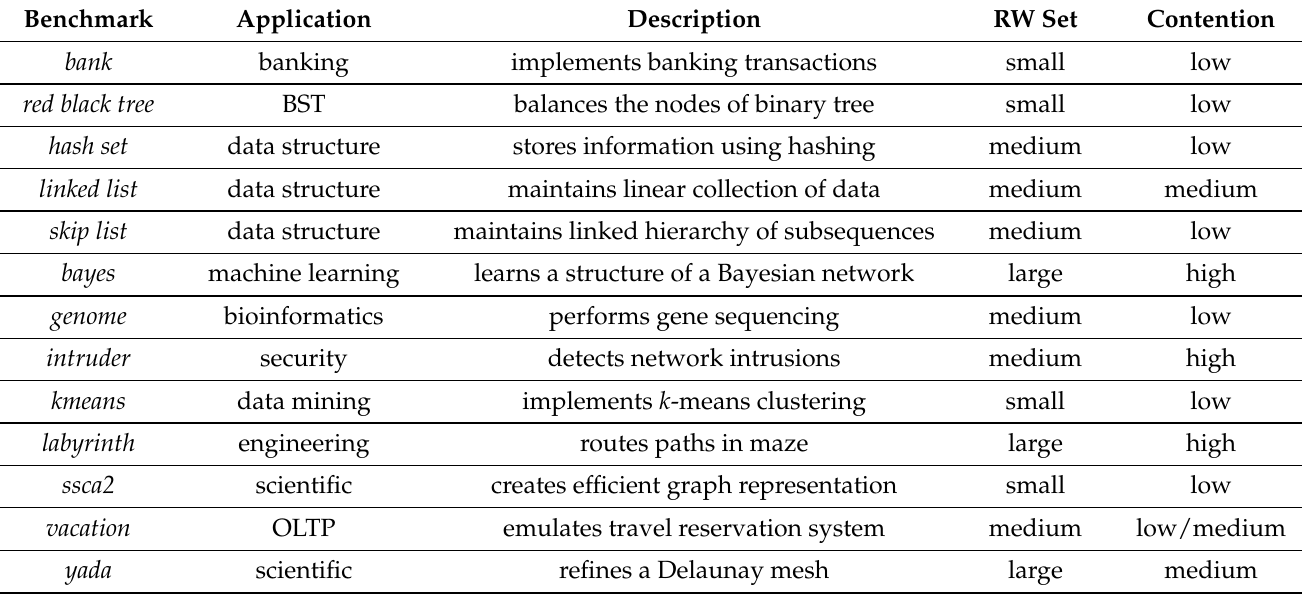
Table 3. Summary of five micro-benchmarks and eight complex benchmarks in STAMP (and STAMPEDE) benchmark suite, including some of their properties.